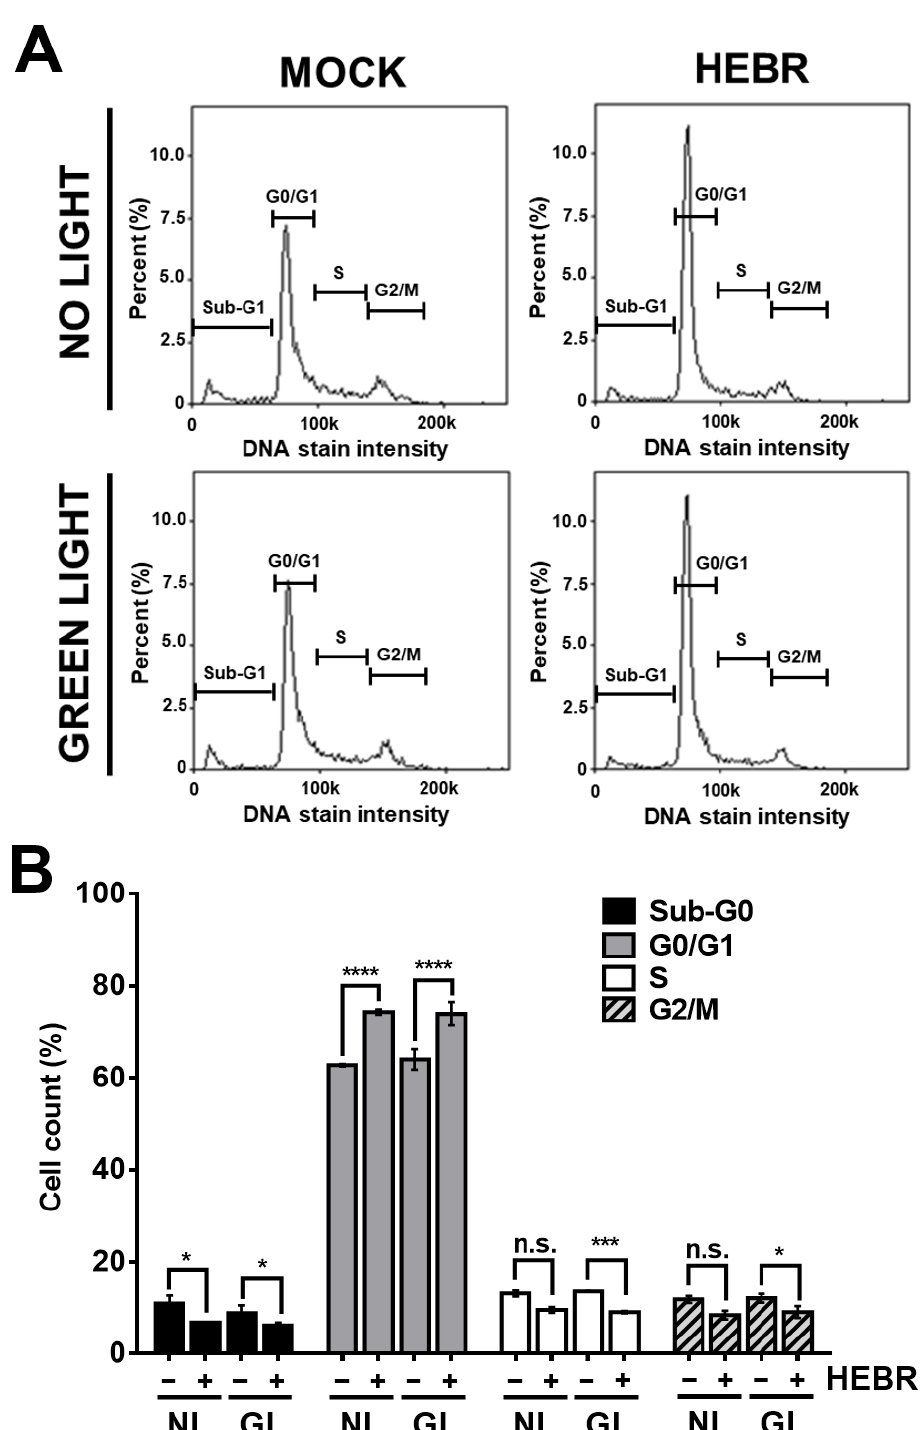
Figure 2. The induction of G 0 /G 1 cell cycle arrest by HEBR. ( A ) The two-step cell cycle assay was used to detect the cell cycle distribution in A549. Cells were treated with HEBR protein (20 µ g/mL) for 24 h with and without green-light illumination. Cells in different cell cycle stages were demarcated by the markers. ( B ) The markers of different cell cycle stages were transformed into histograms by GraphPad Prism 5 software. NL, no light illumination; GL, with green-light illumination. Asterisks indicate statistically significant differences, * p ≤ 0.05, *** p ≤ 0.001, **** p ≤ 0.0001.